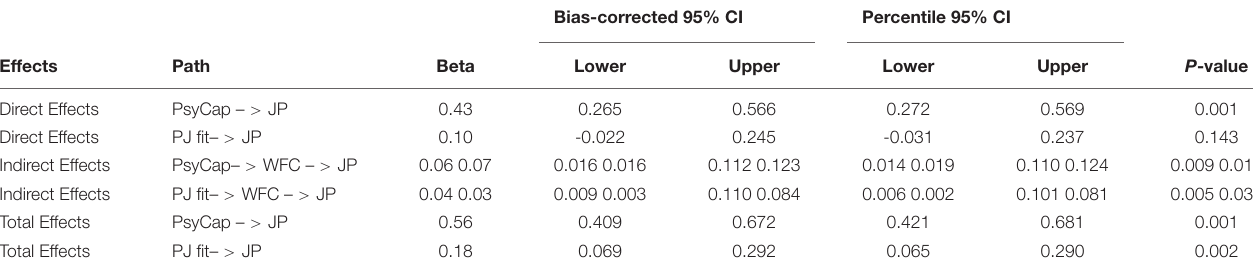
TABLE 5 | Results of the mediation analysis.